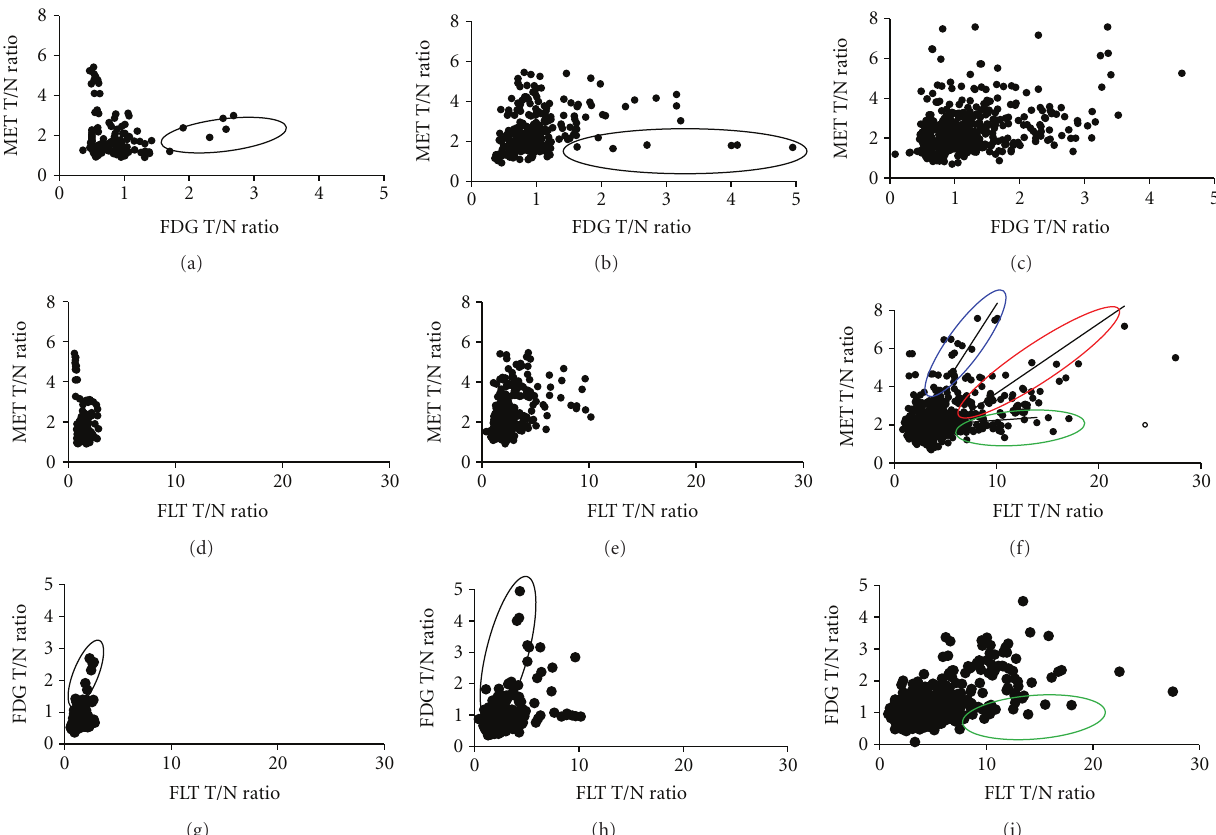
Figure 3: Linear regression analysis of T / N ratio between FDG and MET (grade II (a), grade III (b), grade IV (c)), between FLT and MET (grade II (d), grade III (e), grade IV (f)) or between FDG and FLT (grade II (g), grade III (h), grade IV (i)). A significant but weak correlation is observed between the individual T / N ratio of FDG and MET ( r = 0 . 57, P = 0 . 03) (c). FDG T / N ratio tended to be high correlating with low MET T / N ratio showing a tendency toward the focus of the epileptic changes (black circle). On the other hand, no significant correlation is observed between the individual T / N ratio of FLT and MET ( r = 0 . 13, P = 0 . 61) (f). This relationship between FLT and MET is divided into three parts. Linear regression analysis showed a significant correlation between FLT and MET ( r = 0 . 21, P = 0 . 008) in most areas and these areas appeared as astrocytic tumors (red circle). The T / N ratio of the MET tended to be high without correlating with increased T / N ratio of the FLT ( r = 0 . 53, P = 0 . 014) because the oligodendroglioma components were included (blue circle). The T / N ratio of the MET tended to be low without correlating with increased T / N ratio of the FLT ( r = 0 . 12, P = 0 . 11) because the necrotic components were included (green circle). A significant correlation is observed between the individual T / N ratio of FDG and FLT in the grade IV gliomas ( r = 0 . 54, P = 0 . 05) (i). Between FDG and FLT, T / N ratio of the FDG tended to be high with correlating with low T / N ratio of the FLT showing a tendency toward the focus of the epileptic changes (Figures 3(g) and 3(h) black circle). The T / N ratio of the FDG tended to be low without correlating with increased T / N ratio of the FLT, because the necrotic components were included in the grade IV gliomas (Figure 3(i), green